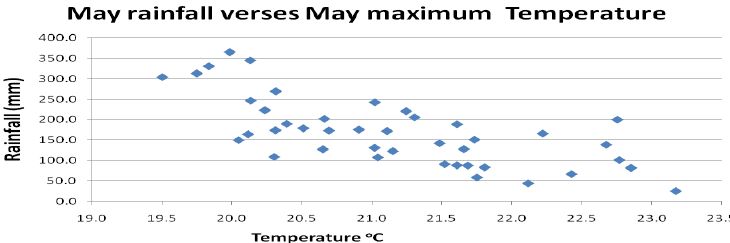
Figure 14. The scatter diagram showing the relationship between May rainfall and maximum temperatures.